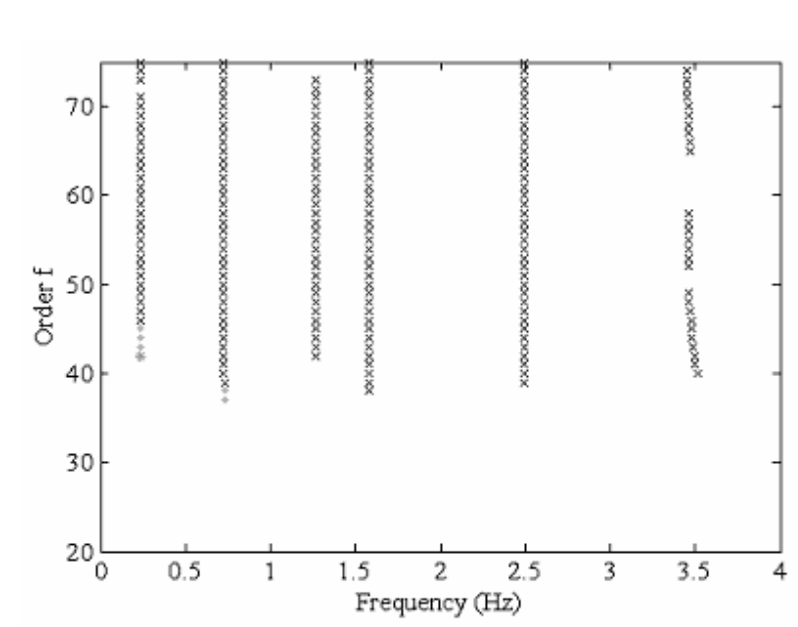
Fig. 1. (a) Main structure of the tower and accelerometers location; (b) Stabilization